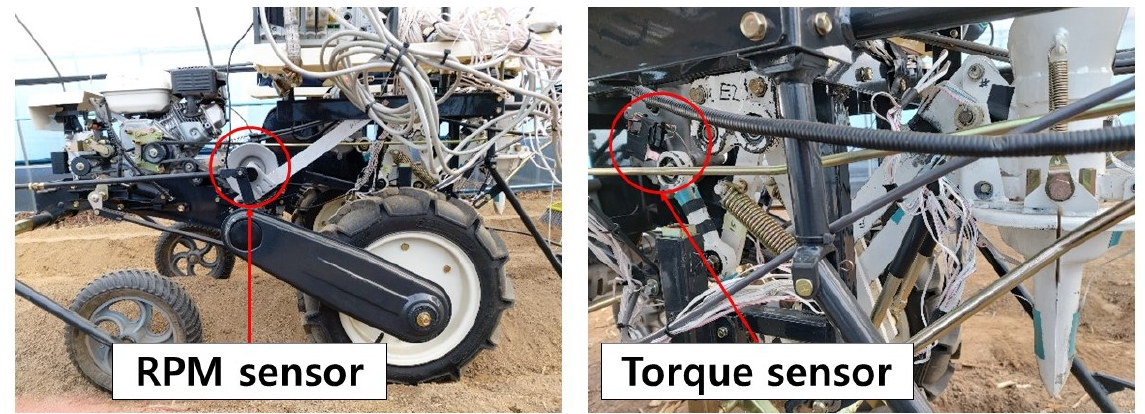
Figure 7. Location of torque and rpm sensor installed on four-bar-link vegetable transplanter.